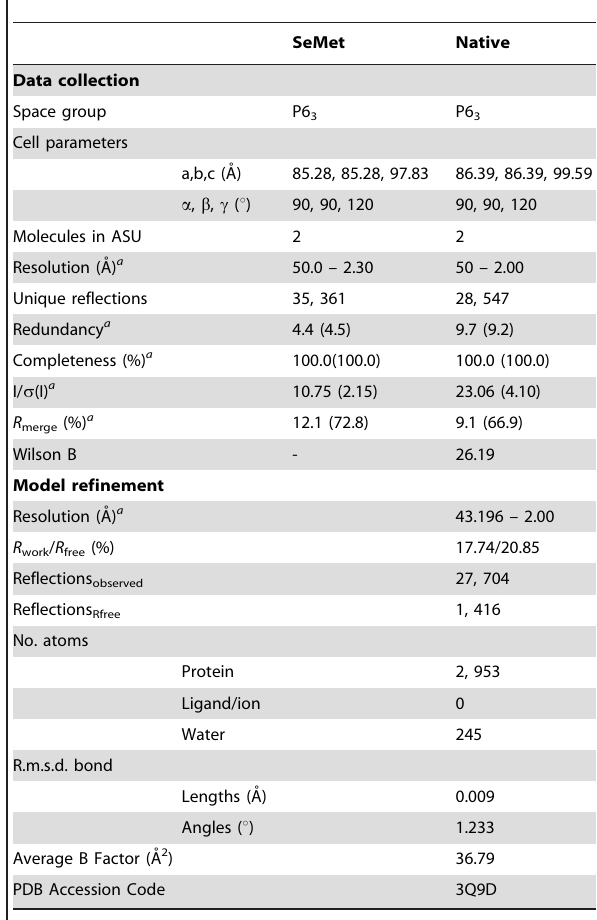
Table 1. Data Collection and Model Refinement